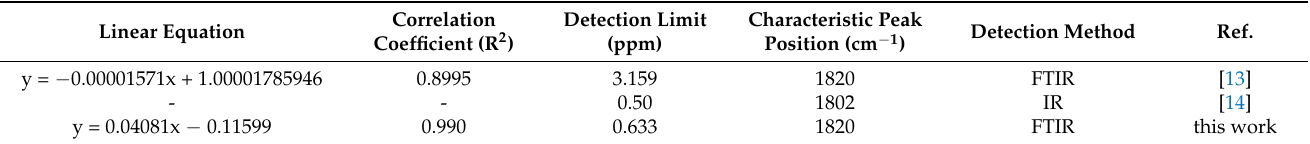
Table 4. Comparison of the CAC determination in TiCl 4 .